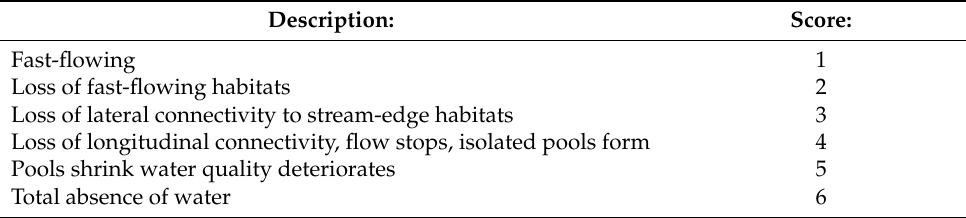
Table 2. Hydrological status